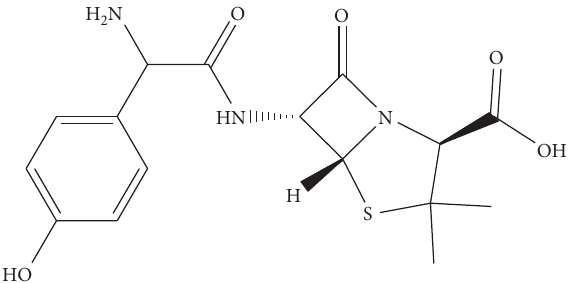
Figure 1: Chemical structure of amoxicillin. The octanol-water partition coefficient (log K ow ) � 0.87, 0.97; acidity constant (pK a ) � 2.4, 2.8, 7.2